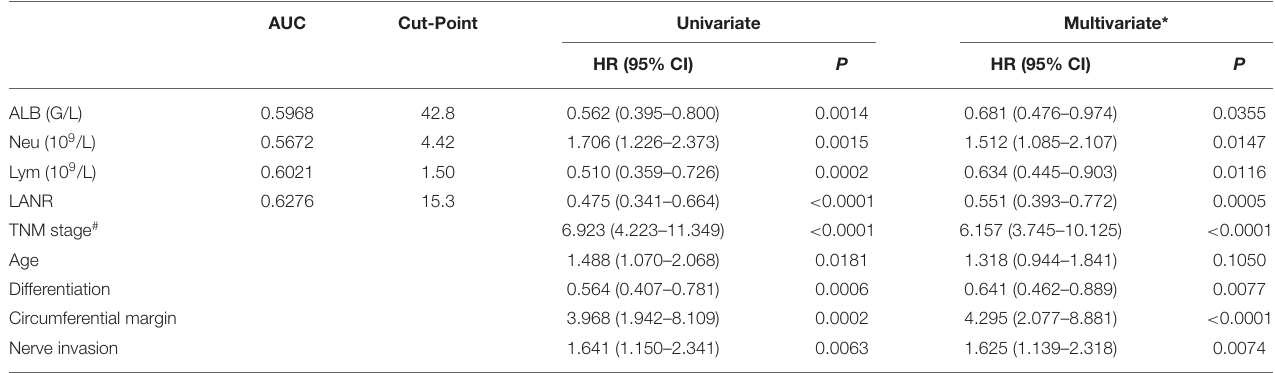
TABLE 2 | Univariate and multivariate Cox regression analysis of overall survival in patients with colorectal cancer. AUC Cut-Point Univariate Multivariate*